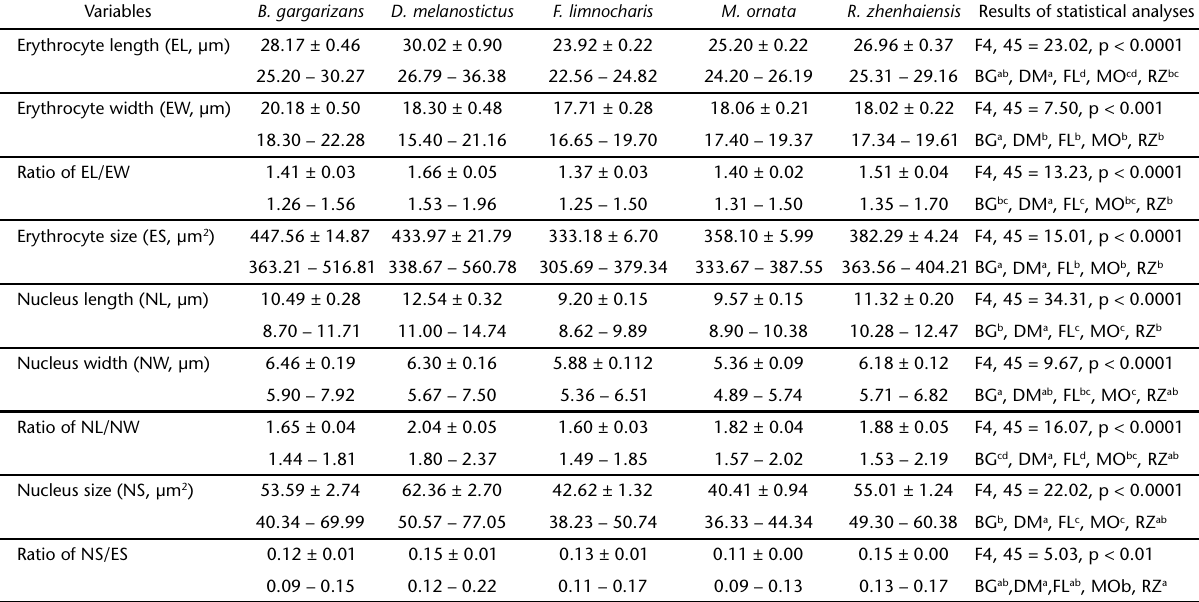
Table 1. Descriptive statistics, expressed as mean ± SE and range, for morphological traits of erythrocytes in five anuran species in Lishui, China, and results of one-way ANOVA for each variable of erythrocytes with species as the factor. Variables